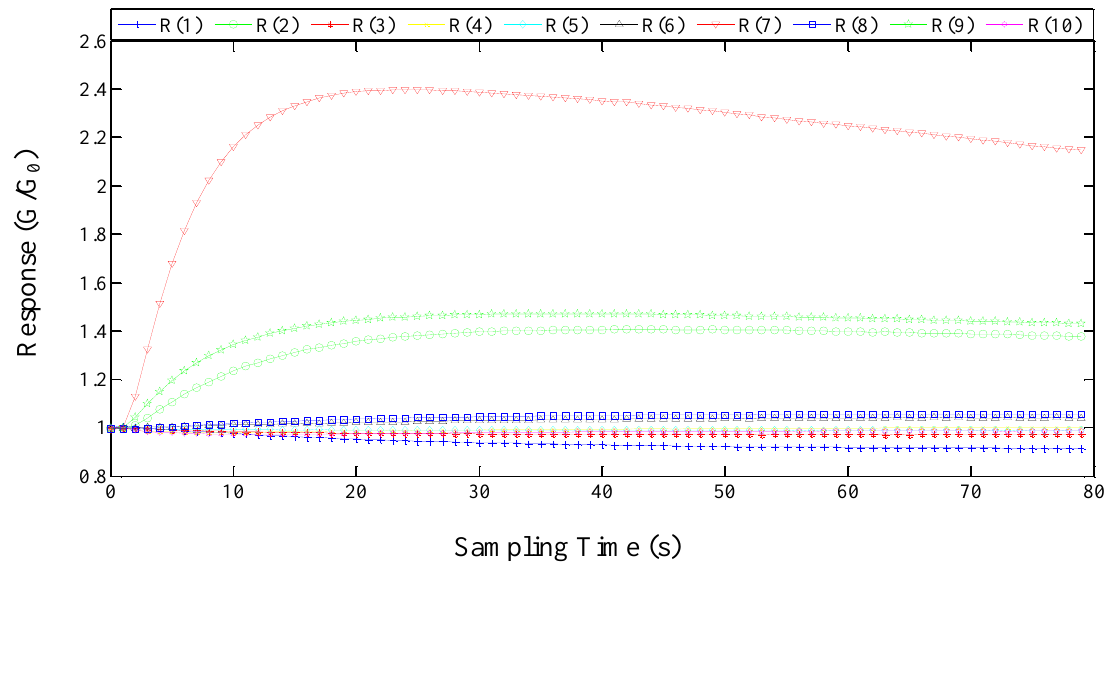
Figure 4. The electrical signal change in volatile detection of “Youyou 122” rice grain